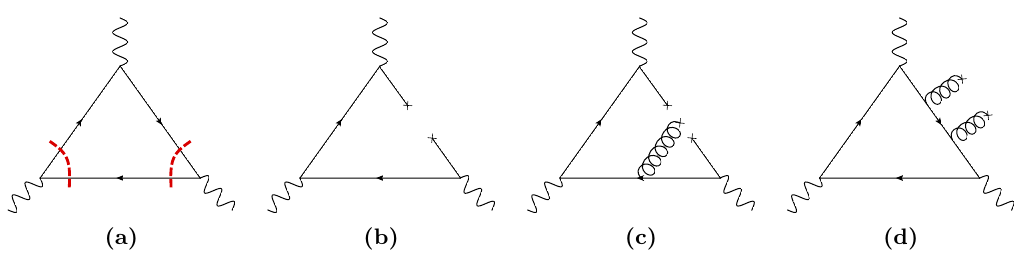
Figure 1 . Contributions to correlation function from left to right: (a) perturbative diagram, (b) nonlocal quark condensate diagram, (c) an example of a quark-gluon condensate diagram, (d) an example of a gluon condensate